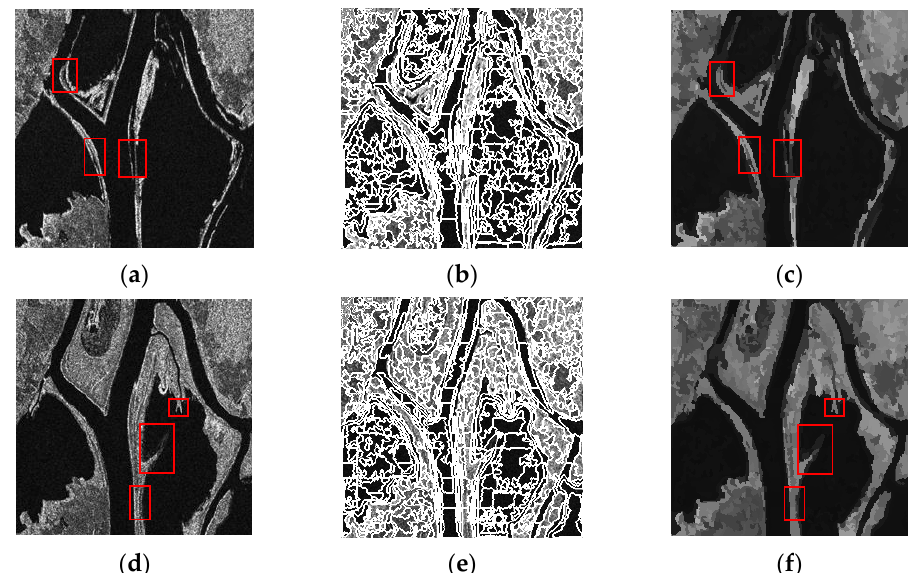
Figure 12. Superpixel segmentation results from the SSN-Siam-diff network for the Ottawa dataset. The first row corresponds to the image captured at 𝒕 𝟏 . ( a ) 𝒕 𝟏 image; ( b ) superpixel generation for 𝒕 𝟏 image; ( c ) the pixel value is replaced by the mean value of the superpixel to which this pixel belongs. Similarly, ( d – f ) correspond to the results of the image captured at 𝒕 𝟐 . The areas marked by red boxes deserve more attention.